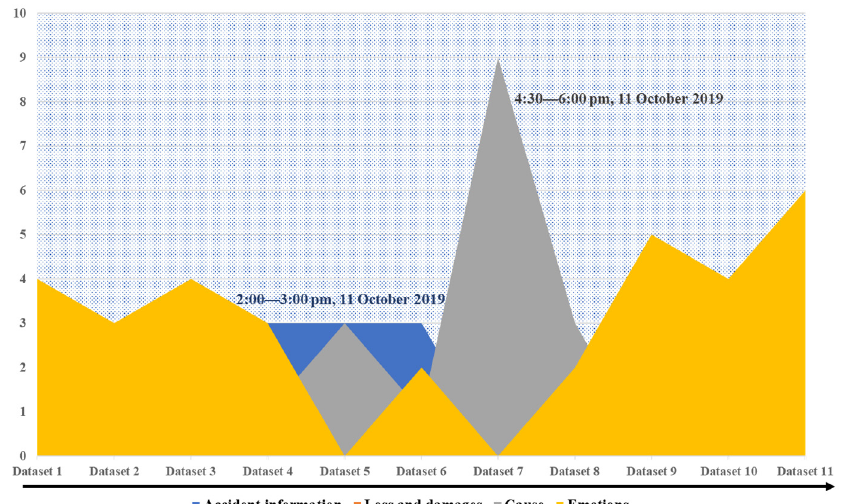
Figure 11. Temporal variations in the topic discussions.